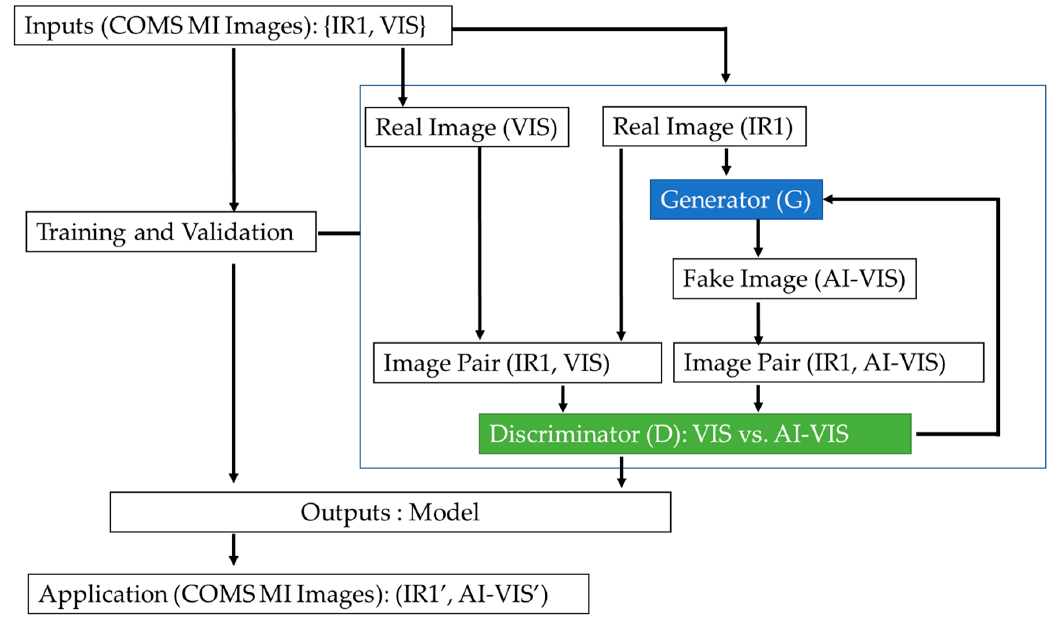
Figure 2. Model structure of our research.